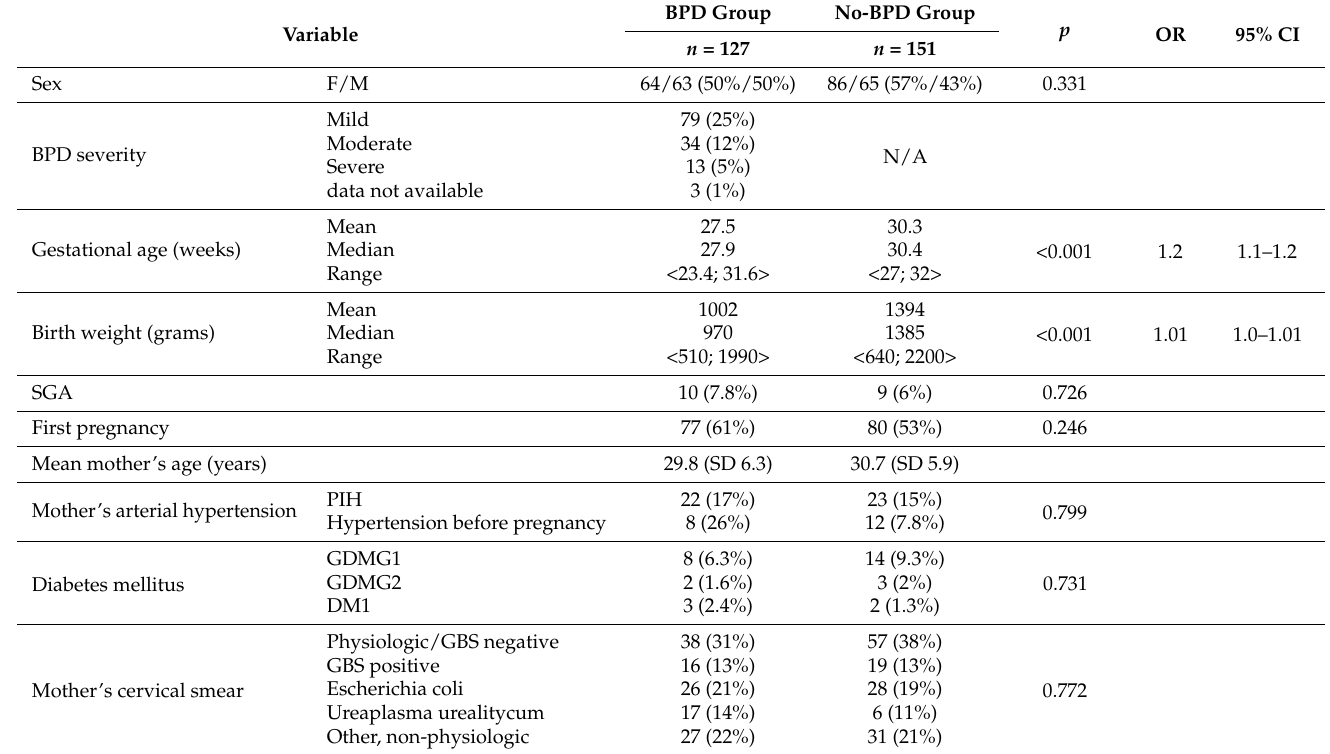
Table 1. Patient